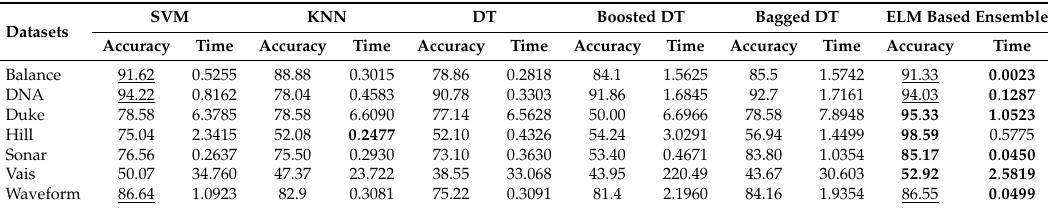
Table 7. Performance comparison of ELM based ensemble with SVM, KNN, DT, Boosted DT, and Bagged